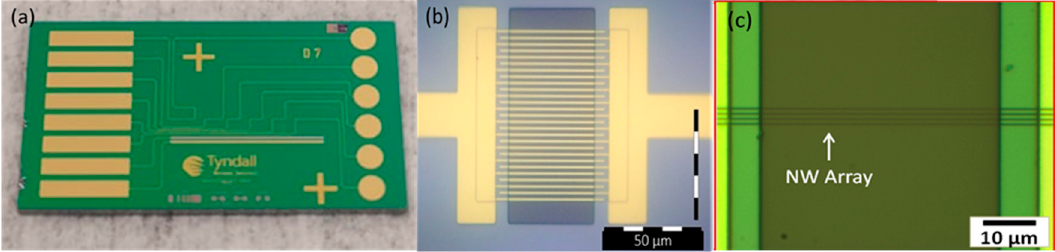
Figure 1. ( a ) Image of the fully fabricated chip with 6 sensors, counter and reference electrodes. ( b ) Higher magnification image of one IDE sensor. ( c ) Higher magnification image of one nanowire array.